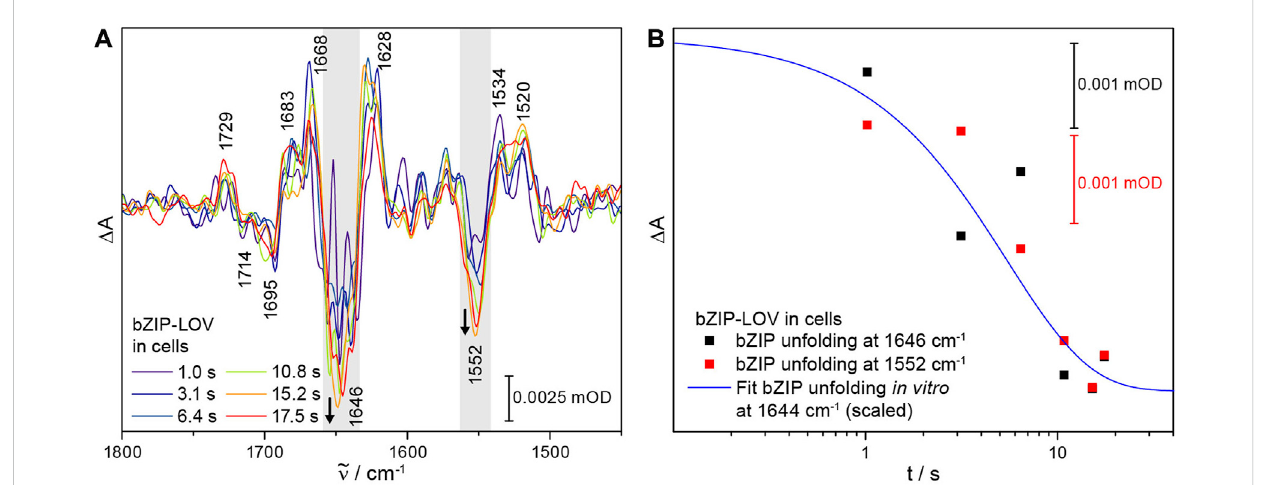
FIGURE 5 Time-resolved ICIRD spectra of bZIP-LOV from Pt Aureo1a in E. coli cells and kinetics of selected bands. (A) The time-resolved difference spectra show characteristic signalsof adduct formation and changes intheamide Iand amideII range (highlightedingray). (B) The processof light-induced bZIP unfolding in cells takes place within seconds, as observed at the amide I signal at 1646 ( − ) cm − 1 (mean absorbance from 1657 to 1644 cm − 1 ) and at the amide IIsignal at1552 ( − )cm − 1 (meanabsorbance from1557 to1542 cm − 1 ).The fi tfrom invitro experiments on thebZIPunfoldingat1644 cm − 1 was added to guide the